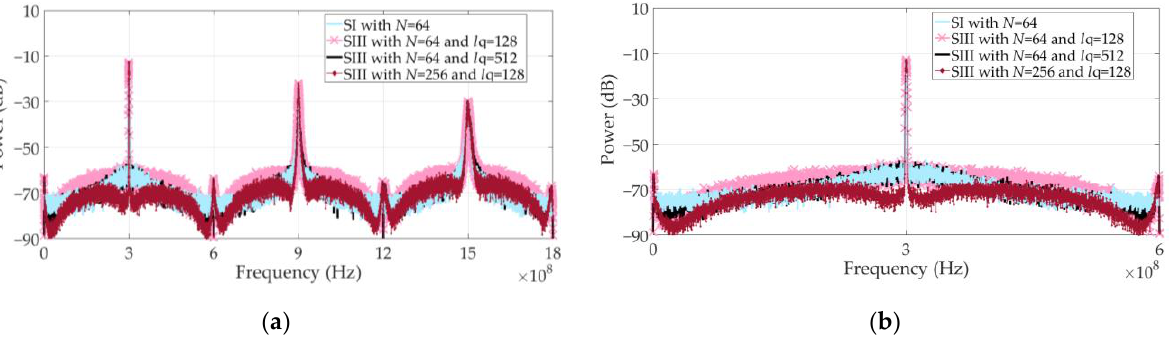
Figure 8. Effect of l q and N on out-of-band noise (BW = 5 MHz). ( a ) Overall output spectrum; ( b )